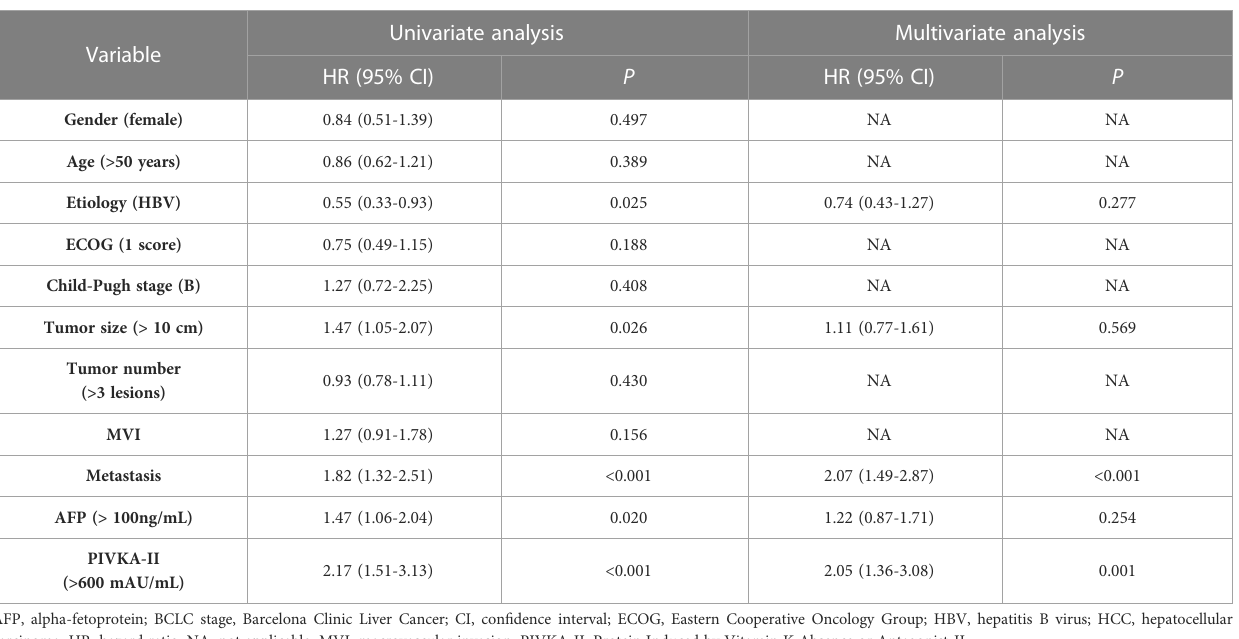
TABLE 2 Univariate and multivariate competing risk analyses to identify independent risk factors of OS in patients with unresectable HCC treated with lenvatinib monotherapy or lenvatinib plus ICI.